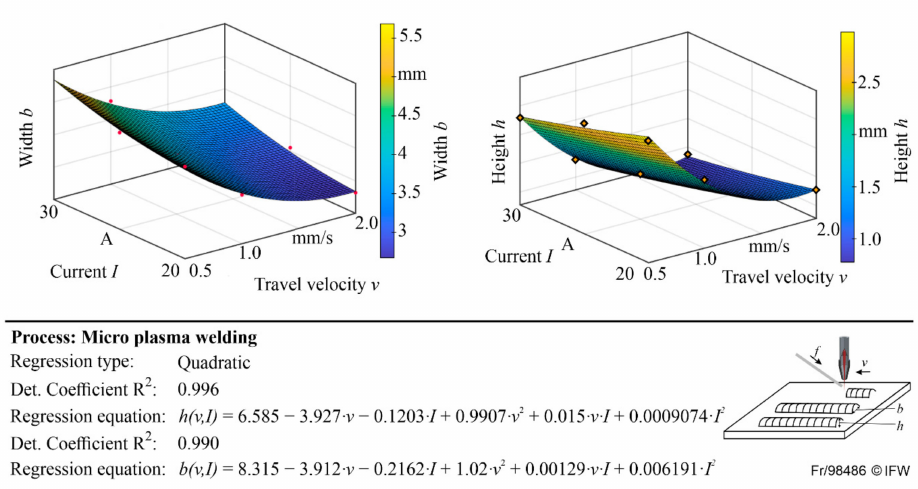
Figure 8. Quadratic regression model for prediction of height and width of deposited material.